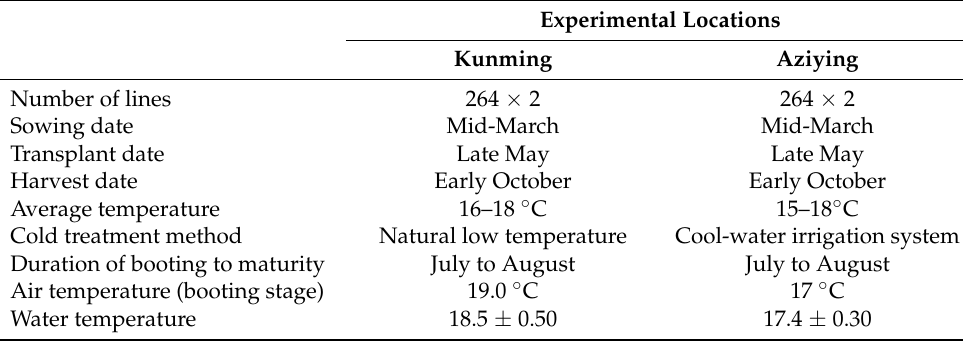
Table 1. Experimental design and field conditions in this